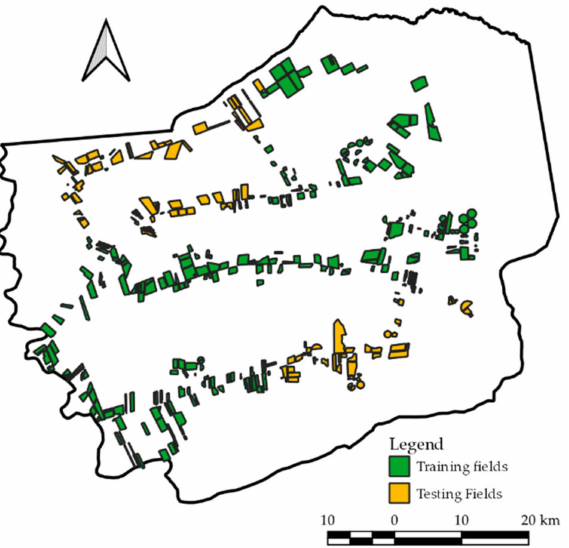
Figure 2. Lu í s Eduardo Magalh ã es municipality boundaries with ground truth polygons highlighting training and testing